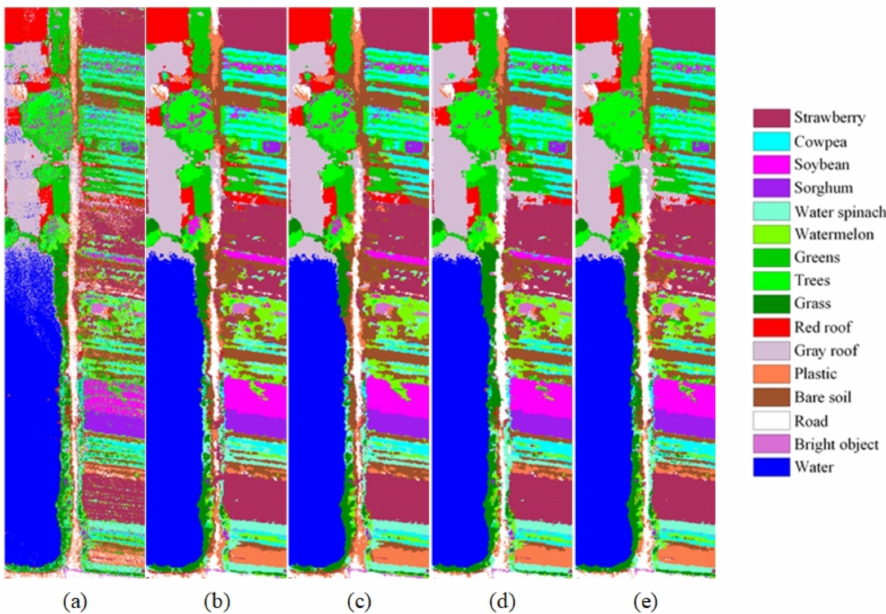
Figure 12. The classification results for the Hanchuan dataset using SVM: ( a ) Pixel-wise spectral classification; ( b ) MLF; ( c ) MPF; ( d ) MLV; ( e ) MPV.